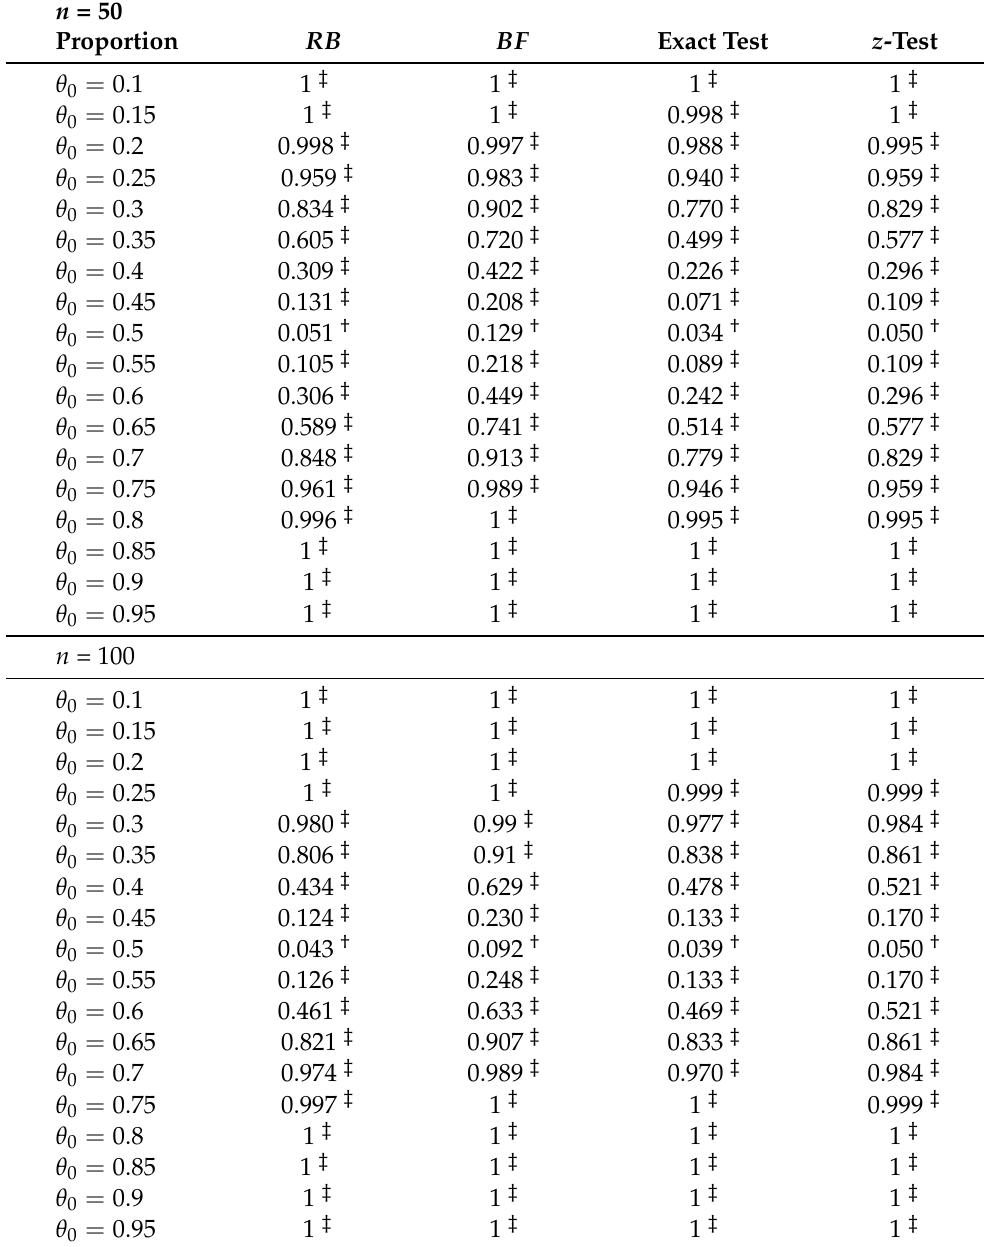
Table 4. The proportion of rejecting H 0 out of 1000 replications based on samples of size n = 50 and n = 100 is reported. Here, † represents the ratio of false positives for the tests and ‡ represents the ratio of the true